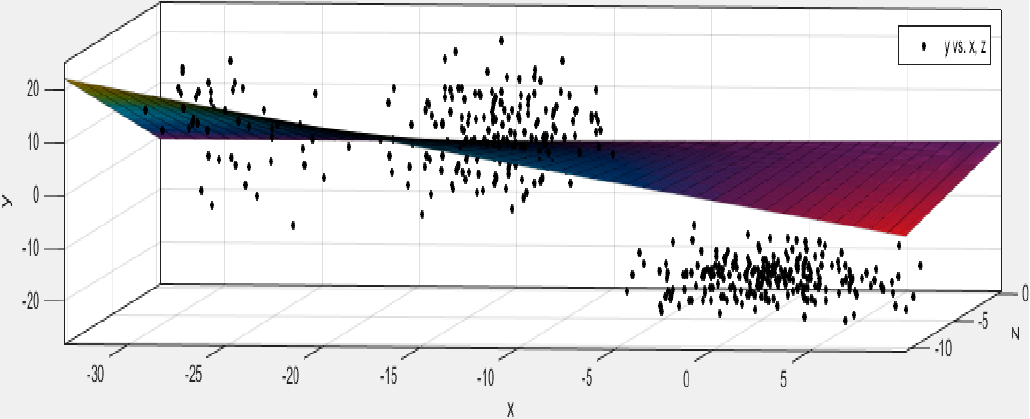
Figure 10. Fitting chart of traffic flow data at 5 s interval.